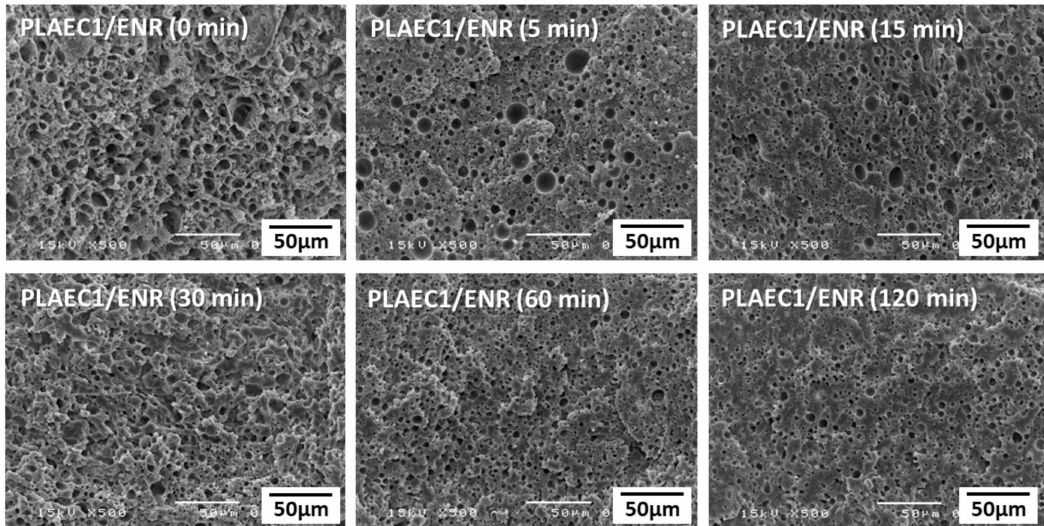
Figure 6. SEM micrographs of the PLAEC1/ENR blend after annealing (0–120 min) at 80 ◦